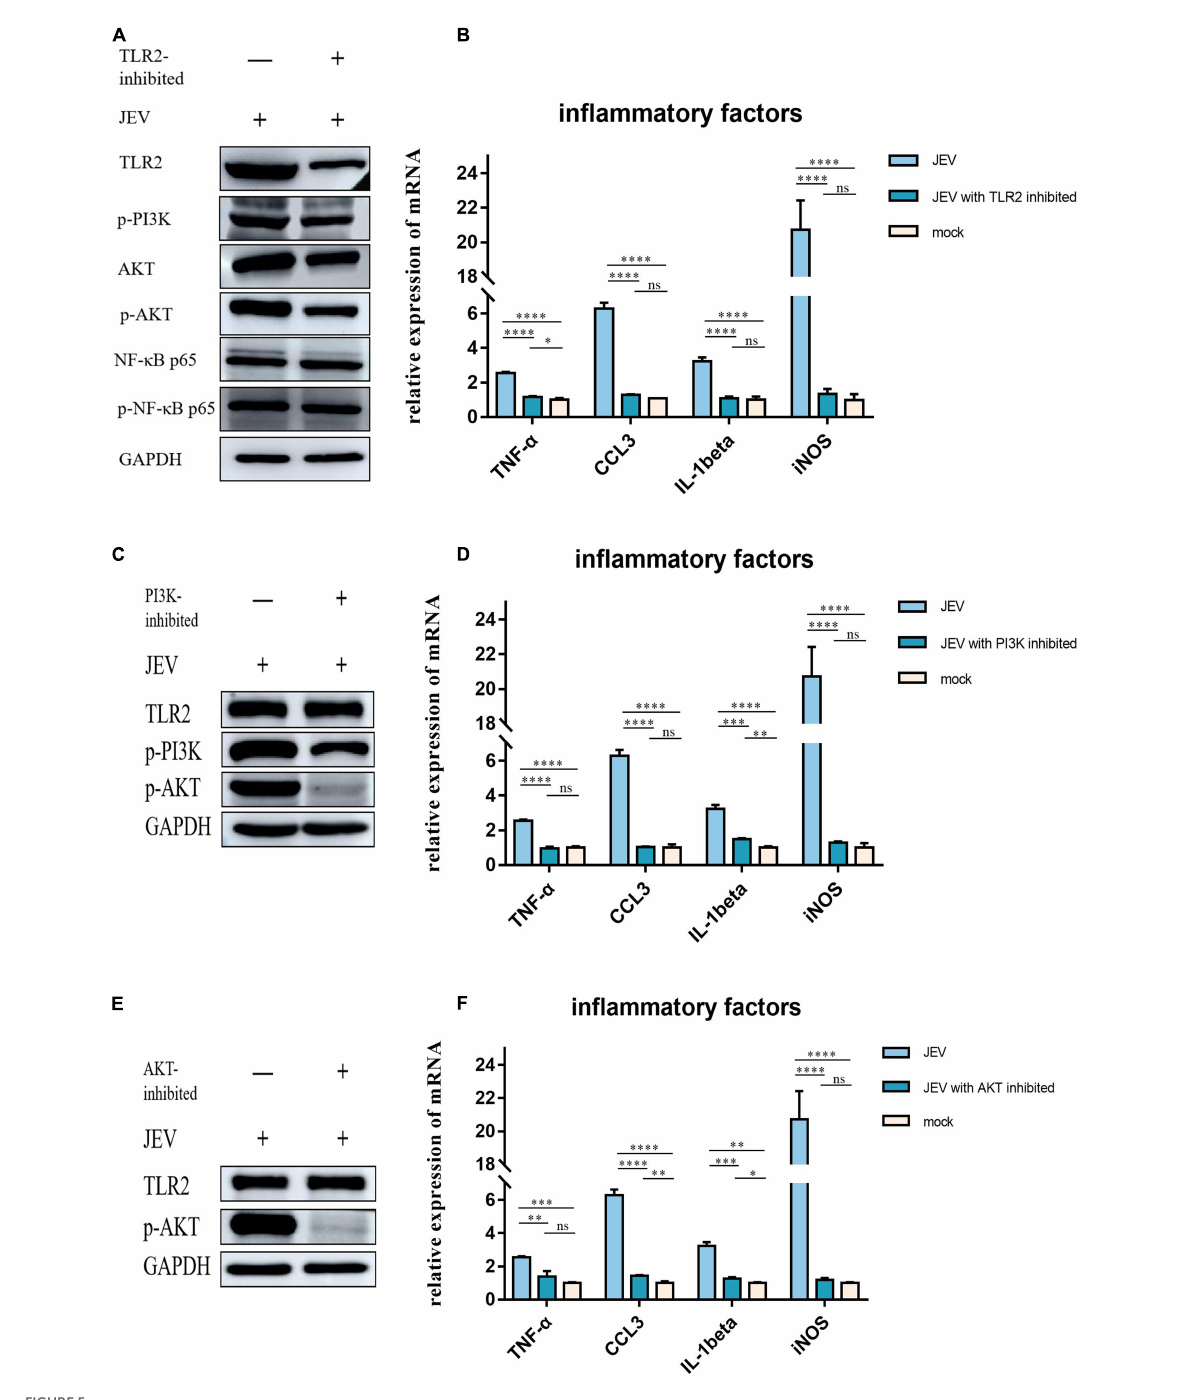
FIGURE5 Regulation of inflammatory factor expression by TLR2 through PI3K and AKT was determined by inhibition of key proteins in the pathway. (A) We subjected TLR2 to inhibition and examined the downstream key proteins (p-PI3K, p-AKT, and NF- κ B). p-PI3K and p-AKT expression decreased with TLR2 expression, whereas NF- κ B and p-NF- κ B did not change with TLR2 expression; these results suggested that PI3K and AKT are downstream of TLR2 and are regulated by regulation of TLR2, rather than the NF- κ B pathway. (B) The expression of key inflammatory factors (TNF- α , CCL3, IL-1beta, and iNOS) were significantly decreased after TLR2 inhibition, thus indicating that TLR2 is a key protein in the regulation of inflammation. (C) PI3K, a key protein downstream of TLR2, was inhibited and the expression of TLR2 remained unchanged, while the expression of AKT was decreased, thus indicating that PI3K acts downstream of TLR2. (D) The expression of key inflammatory factors all decreased after PI3K inhibition. (E) AKT was inhibited but this did not induce changes in TLR2 expression, thus indicating that AKT is a downstream protein of TLR2. (F) The expression levels of TNF- α , CCL3, IL-1beta, and iNOS were all decreased after AKT inhibition. These results suggest that the expression of inflammatory factors is regulated by the TLR2-PI3K-AKT signaling axis. ns: not signifificantly regulated, * P < 0.05, ** P < 0.01, *** P < 0.001, and **** P <